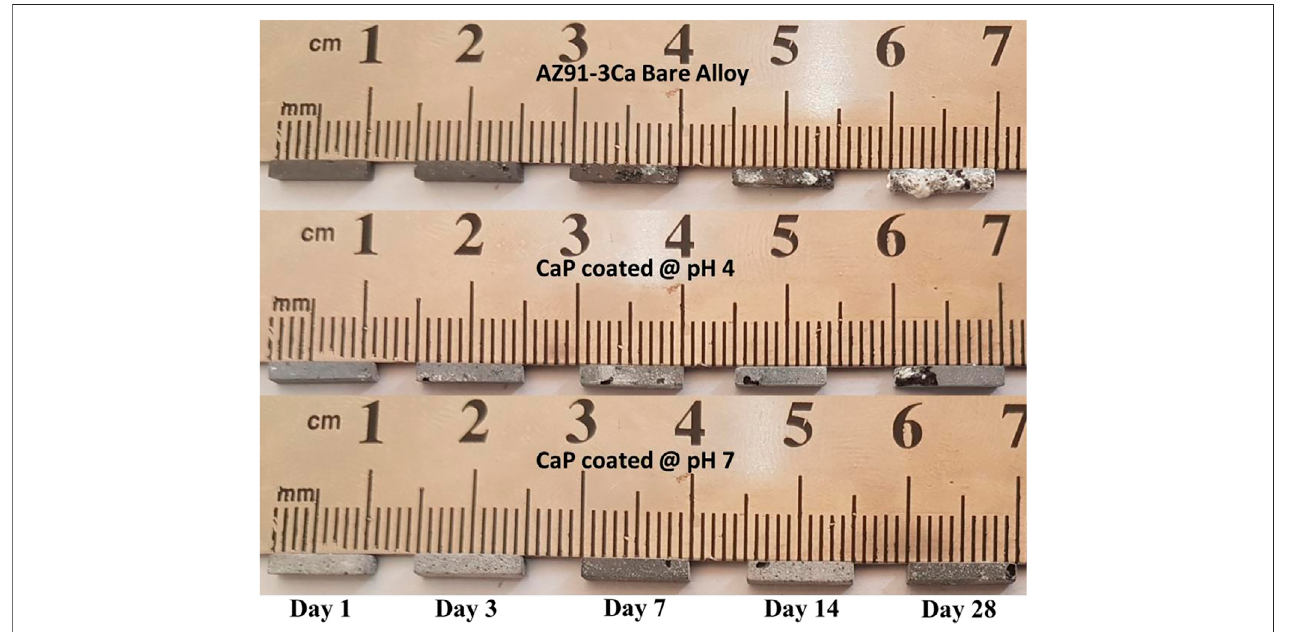
FIGURE 4 | Macrographs of coated and uncoated samples at each prescribed time point of immersion testing in SBF.